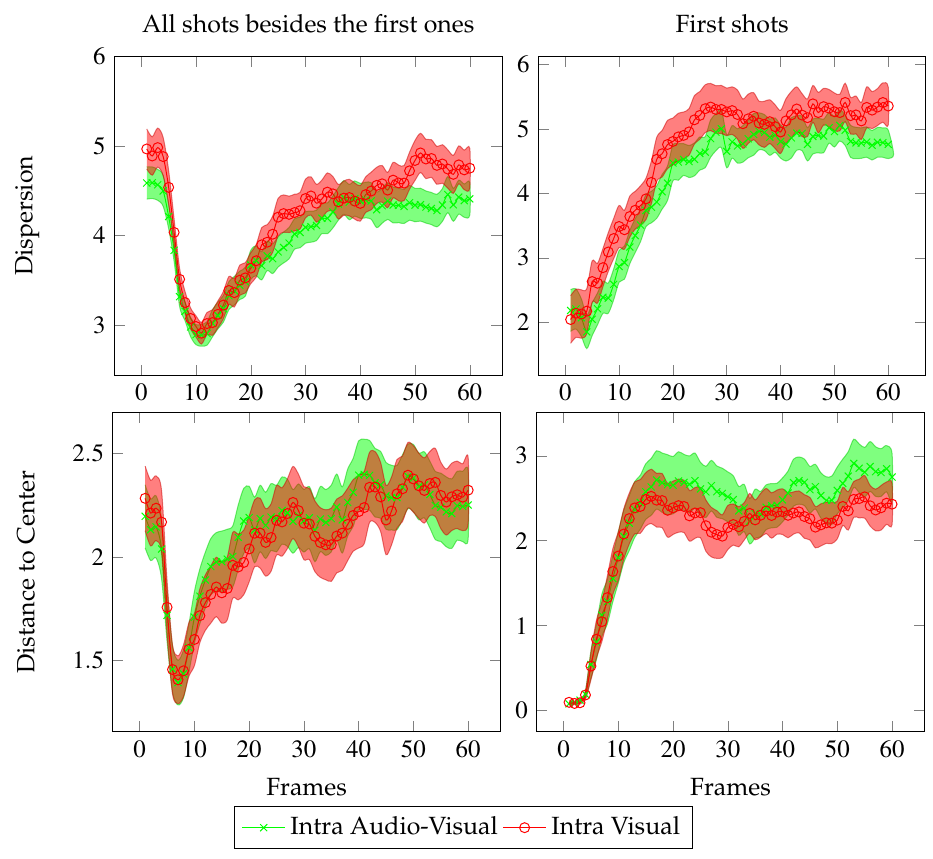
Figure 4 . Temporal evolution of the dispersion (up) and distance to center (down). These values are averaged over all shots except the first ones (113 shots, left plots) and over the first shots (50 shots, right plots). Values are given in degree of visual angle with error bars corresponding to the standard errors.